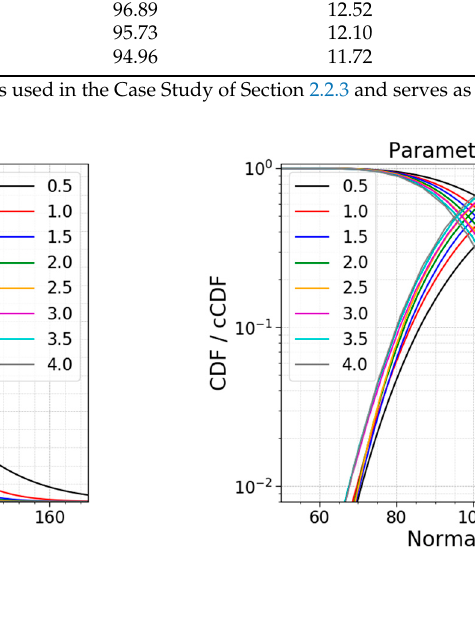
Figure 21. ( a ) PDF and ( b ) CDF for a varying flaw density.